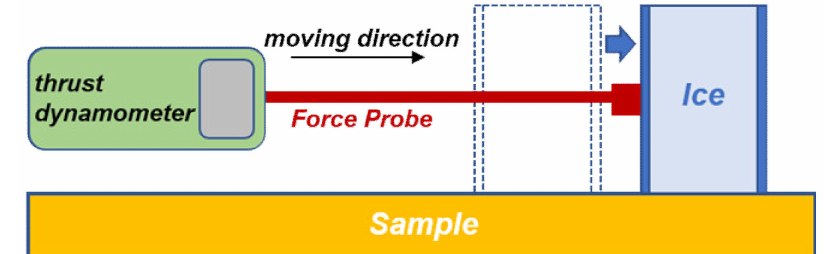
Figure 1. The set-up configuration of the ice adhesion strength